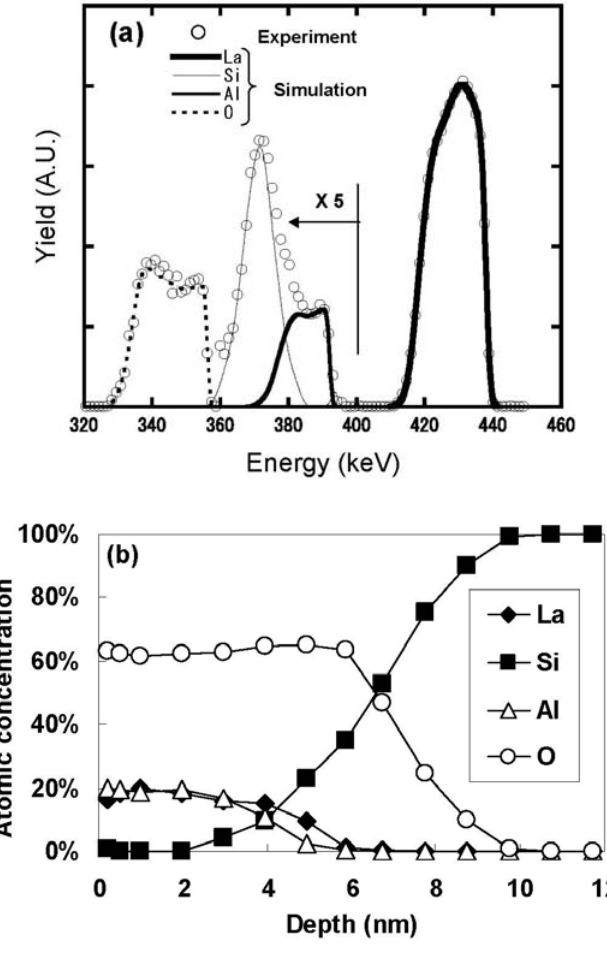
Figure 15. ( a ) HRBS spectrum for the specimen annealed in an oxygen ambient; ( b ) Elemental depth profiles for the specimen annealed in an oxygen